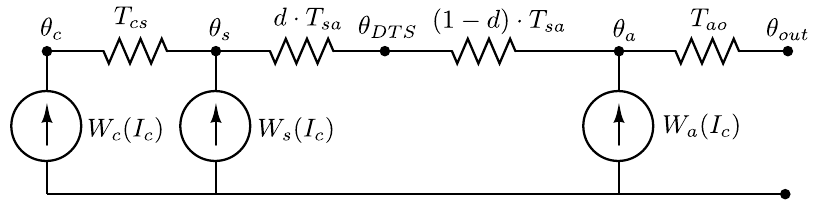
Figure 14. Modified ETN with the DTS